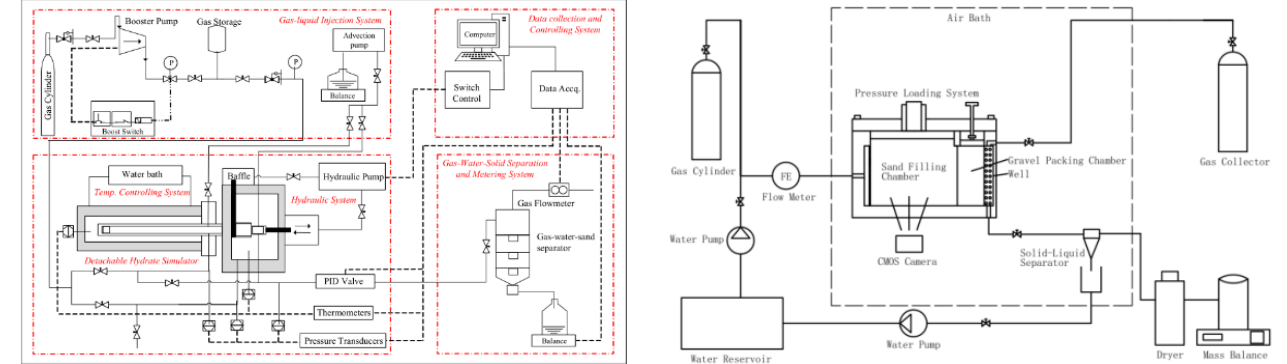
Figure 7. Hydrate sand production simulator [This figure was modified with permission from ref. [138,145]. Copyright 2021, 2022, Elsevier].